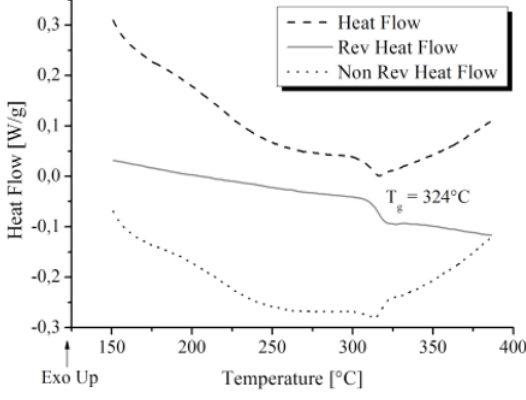
Figure 4. Modulated Differential Scanning Calorimetry of AryLite TM .